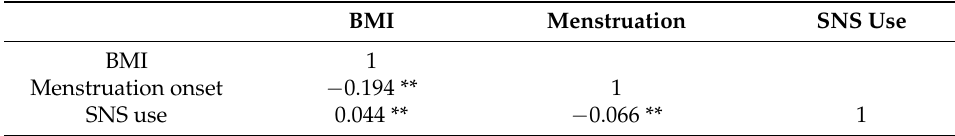
Table 2. Associations between BMI, menstruation onset age and SNS